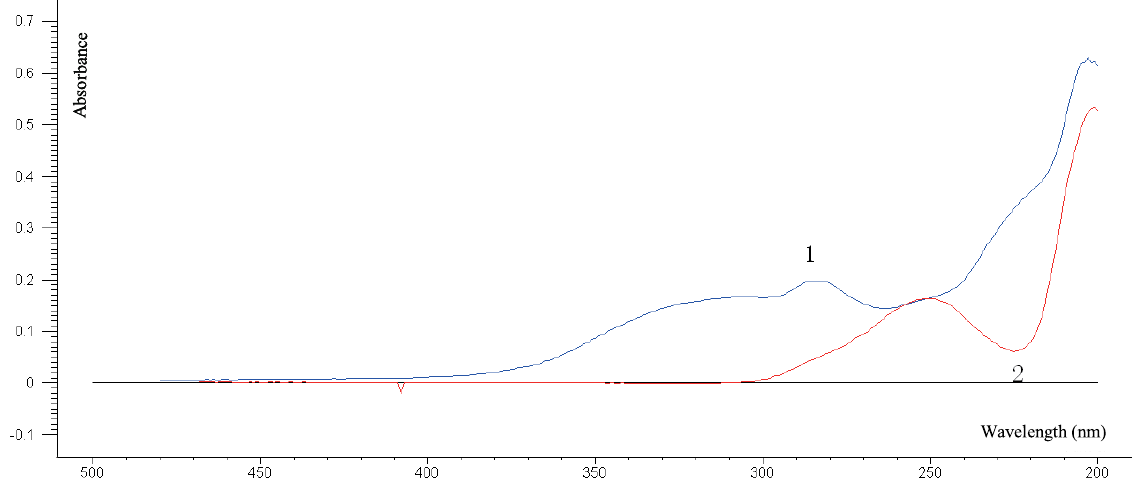
Fig. 2. Comparison of UV spectra of gallic acid reference and a Danshen injection (1, Danshen injection; 2, gallic